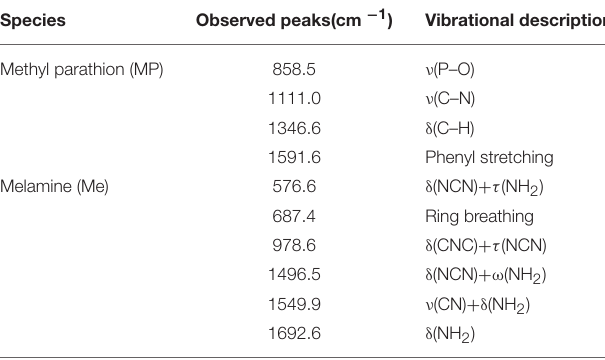
TABLE 1 | Raman scattering peaks assignment for methyl parathion and melamine (Mircescu et al., 2012; Li Z. et al., 2015). Species Observed peaks(cm − 1 ) Vibrational description